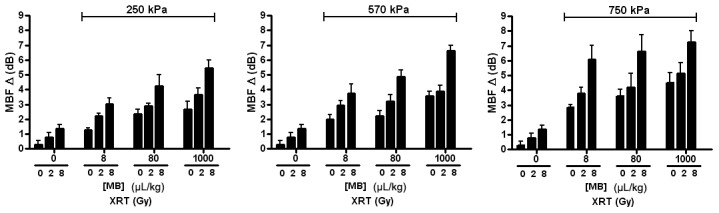
Average changes in midband-fit parameter.Each bar represents the mean of midband-fit values of five mouse-borne tumors (n = 5). The error bar indicates the standard error within the sample size. Statistical testing using 2-way ANOVA indicates the effects caused by the changes in both microbubble concentration and dose of radiation to be very significant for every graph (p<0.0001). Each graph shows the average changes in midband-fit for varied microbubble concentration and radiation doses at a fixed ultrasound pressure: 250 kPa, 570 kPa, and 750 kPa.